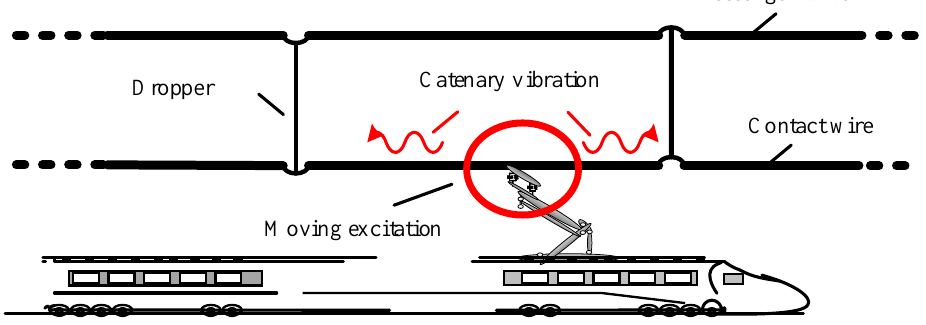
Figure 1. Schematic of the pantograph-catenary system.